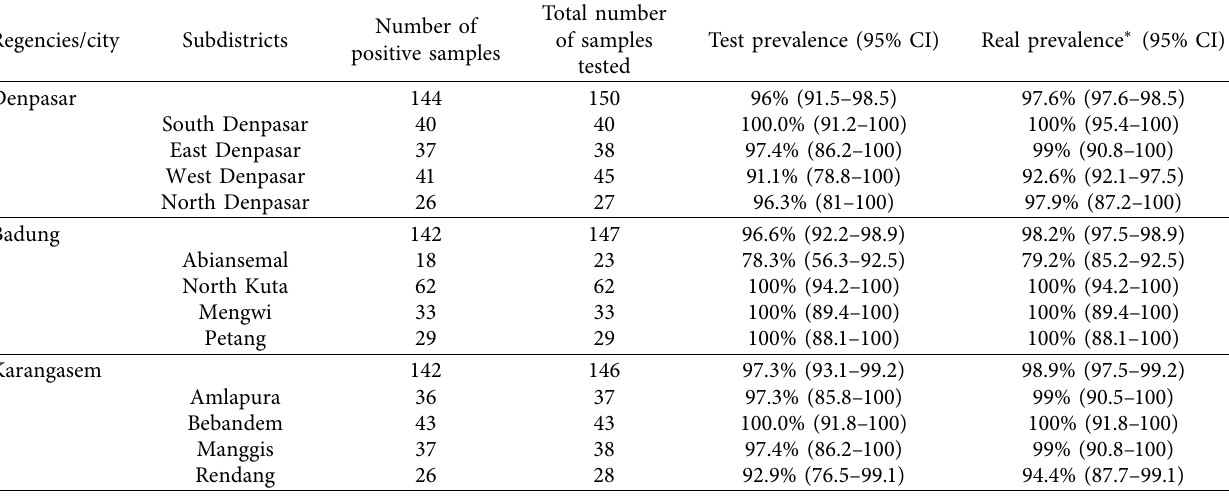
Table 1: Animal-level test seroprevalence and real prevalence of JEV in pig sera collected from the regencies/city of Denpasar, Badung, and Karangasem in the province of